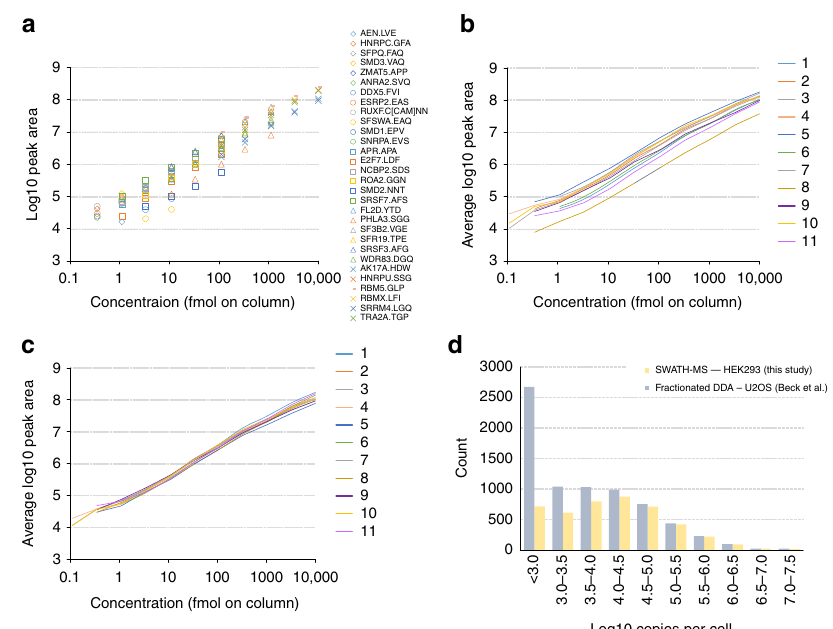
Fig. 4 Dynamic range and linearity. a The response curves for each of the 30 SIS peptides for Site 1 were determined and plotted together (corresponding plots for all other sites are shown in Supplementary Fig. 13). b From this data, an average response curve for each site was constructed by averaging (mean) the responses of peptides at the same concentration point. This visualization facilitates comparison of both the dynamic range and average response between sites. c The average response curves from b replotted after the normalization has been applied. d The proteins detected in the SWATH- MS analysis of the HEK293 proteome matrix were mapped onto a previous in-depth DDA analysis of the U2OS cell line that employed multi-level fractionation to achieve deep proteome coverage. To demonstrate the dynamic range achieved by the single-shot SWATH-MS analysis we plotted the proteins detected by SWATH-MS binned by the protein copies per cell value (log10 scale) determined from the in-depth U2OS DDA study 60 . In the